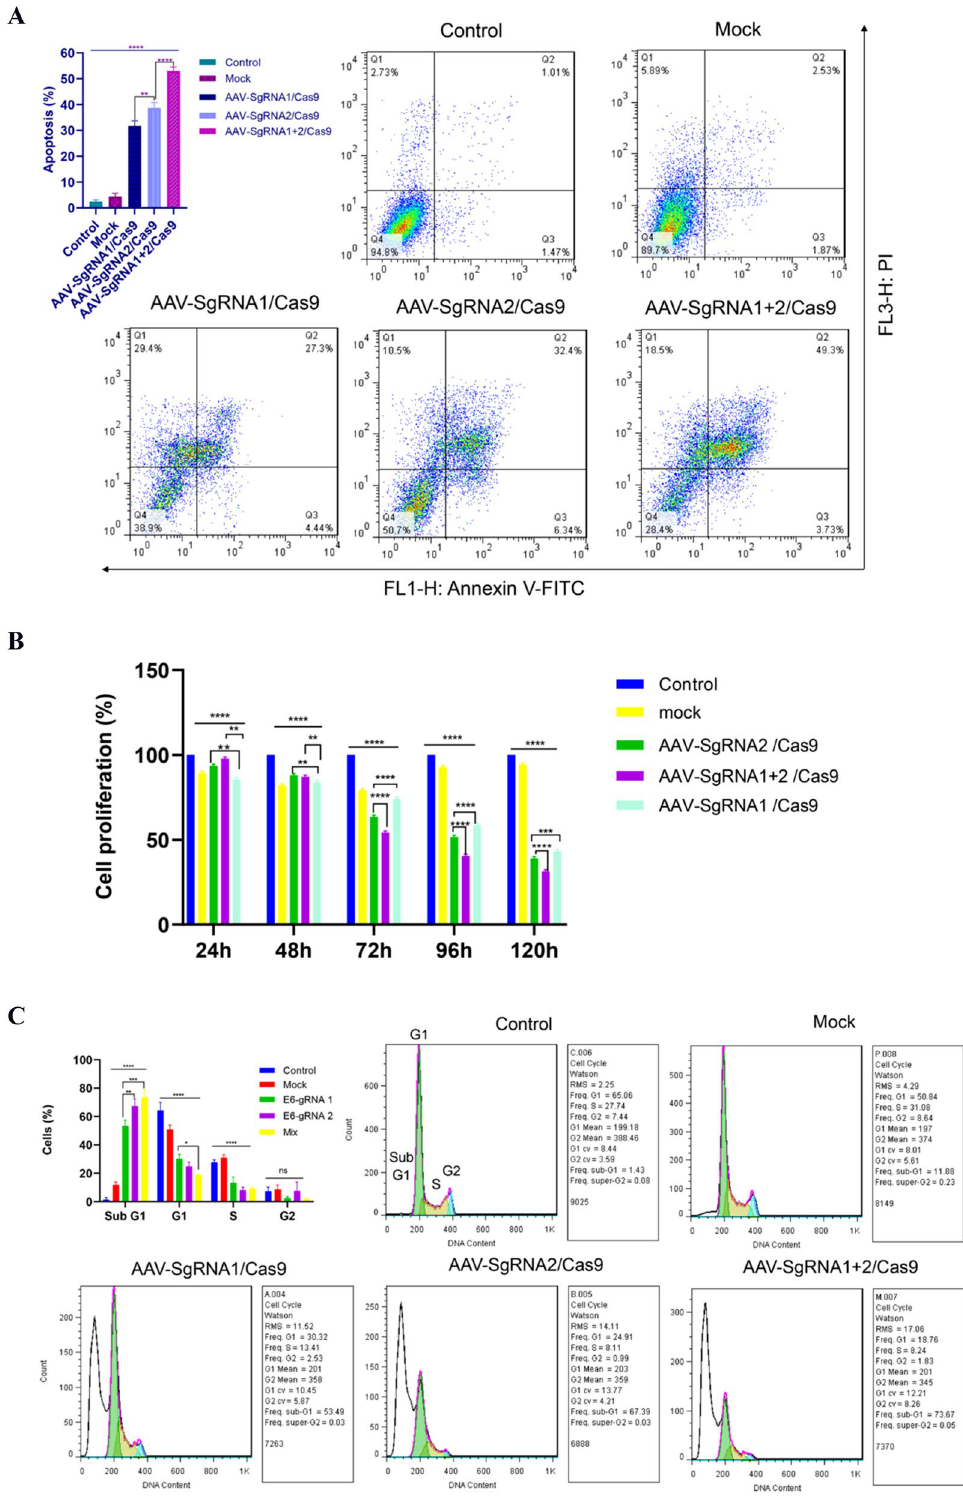
Figure 3. The effect of the gene editing on cell apoptosis ( A ) and proliferation ( B , C ). ( A ) Cells were double-stained with propidium iodide and annexin V-FITC, then the rate of apoptosis was monitored by flow cytometry after 5 days after infection of HeLa cells. Flow cytometry finding indicated that AAV-E6-CRISPR/Cas9 infection significantly induced apoptosis in HeLa cells compared to the control and mock cell groups. ( B ) MTT assay showed that disruption of the E6 gene using AAV-E6- CRISPR/Cas9 could significantly inhibit cell proliferation in HeLa cells. ( C ) Cell cycle profiling showed that AAV-E6-CRISPR/ Cas9-mediated inactivation of the E6 gene resulted in cell cycle arrest in sub G1. The represented data are as mean ± SD independent experiments. Data were analyzed using a one-way ANOVA test. p < 0.05 was used to determine statistical significance (** p -value < 0.01 *** p -value < 0.001 **** p -value <